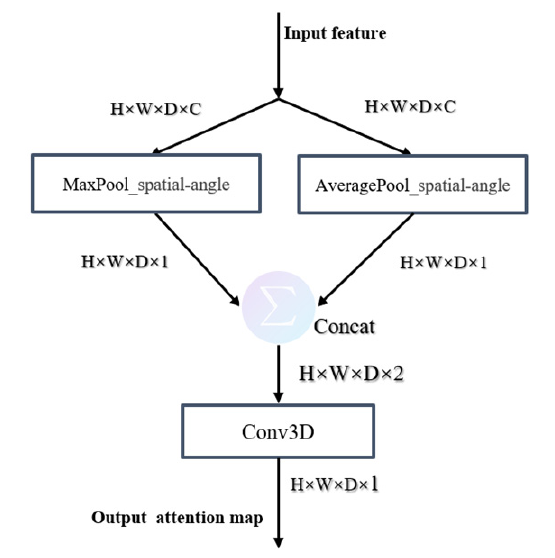
Figure 9. Detailed structure of spatial-angle attention module.